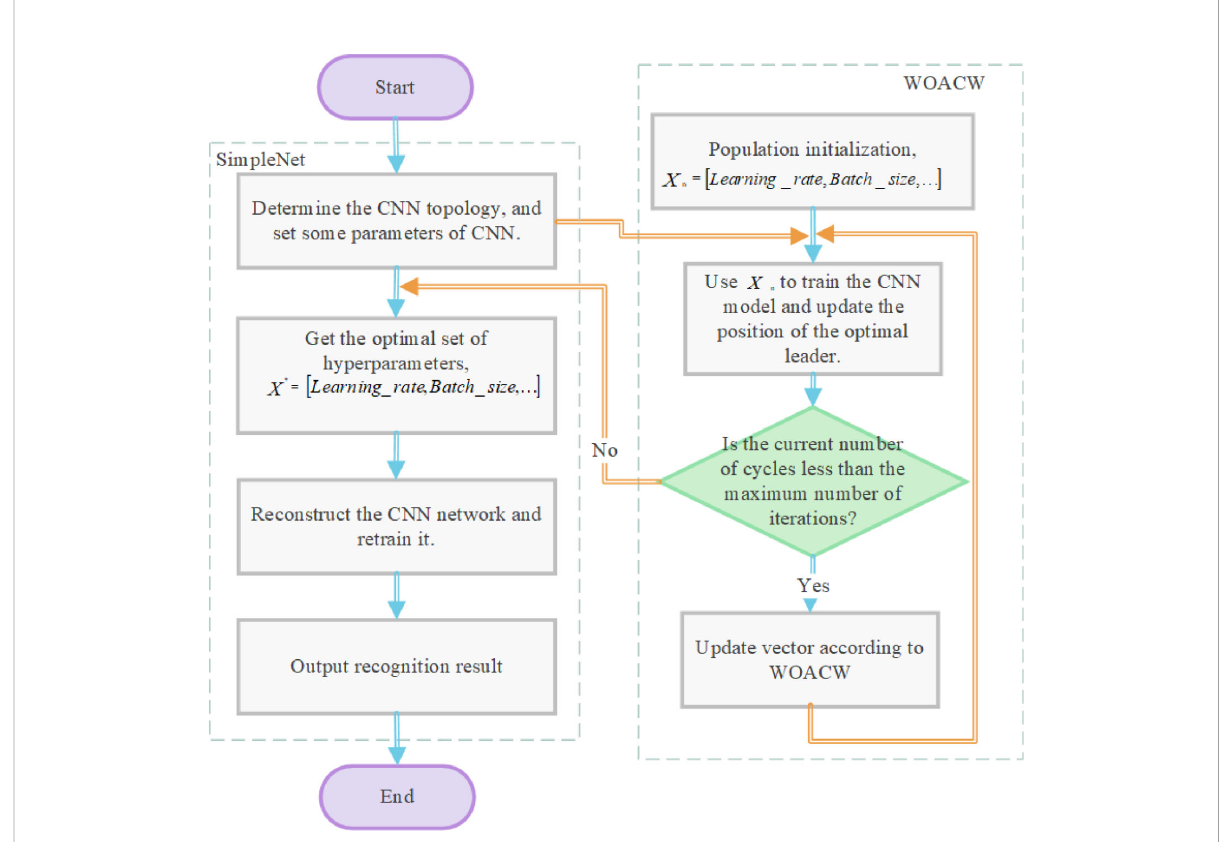
FIGURE 3 WOACW_SimpleNet fl